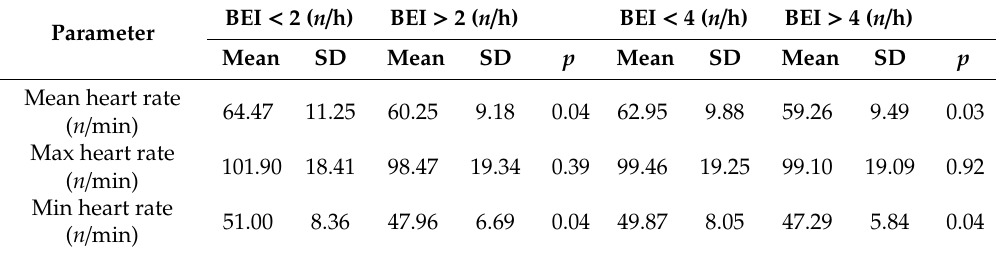
Table 4. Results for heart rate in bruxers and non-bruxers, di ff erentiated on the basis of bruxism severity.